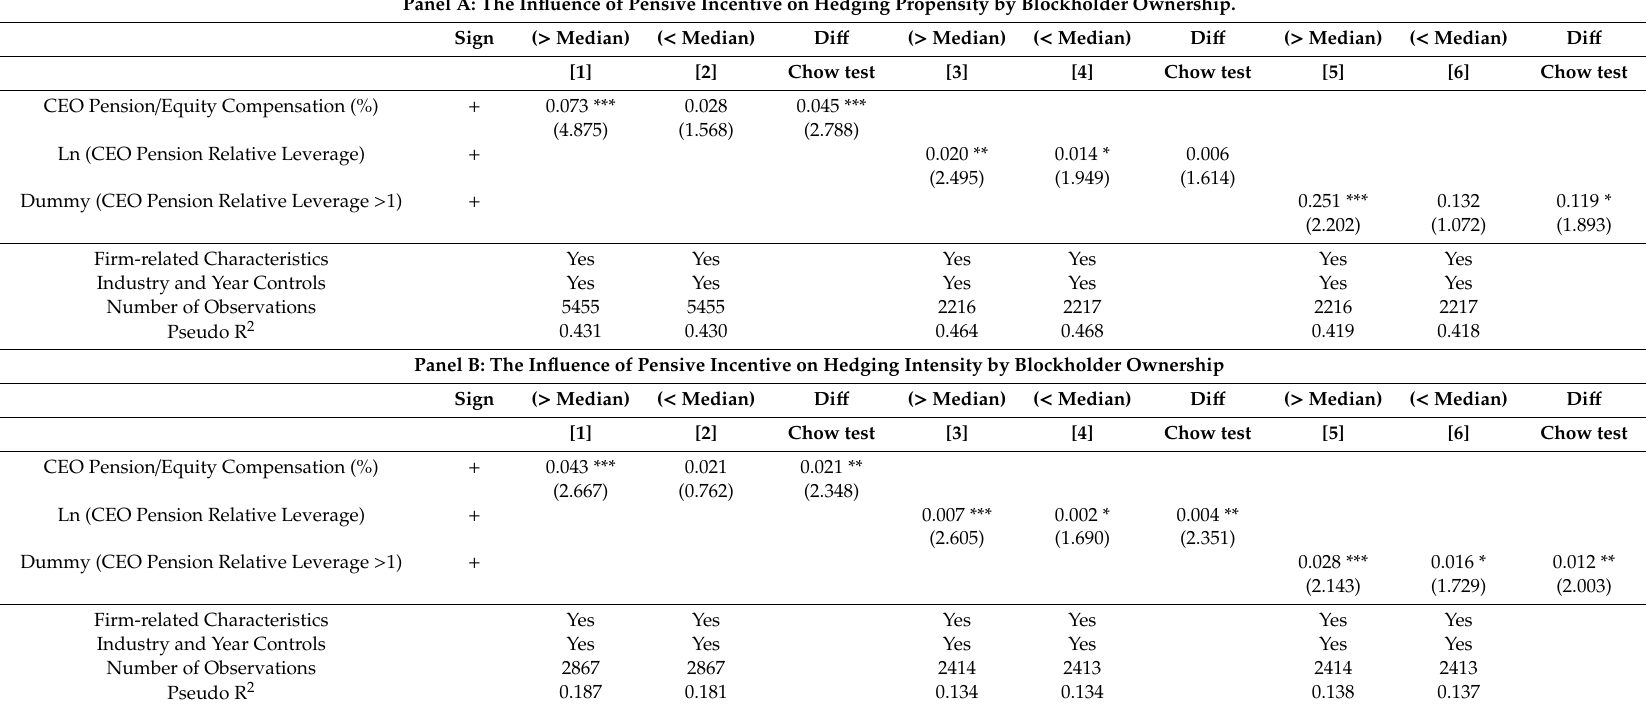
Table 7. The influence of pension incentive on hedging by blockholder ownership. Panel A: The Influence of Pensive Incentive on Hedging Propensity by Blockholder Ownership.